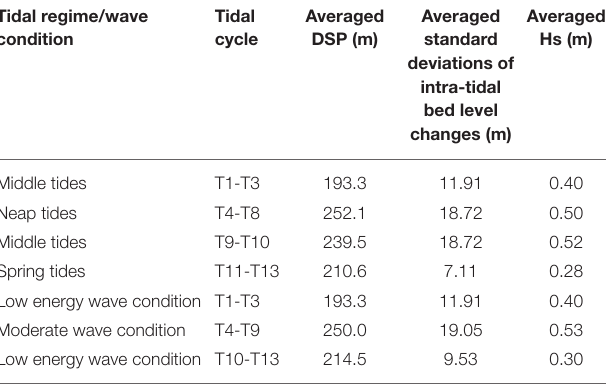
TABLE 4 | The statistics of distances of seabed to ADV probe over tidal cycles (averaged DSPs), standard deviations of intra-tidal bed level changes, and averaged significant wave heights (averaged Hs) classified by tidal regimes and wave